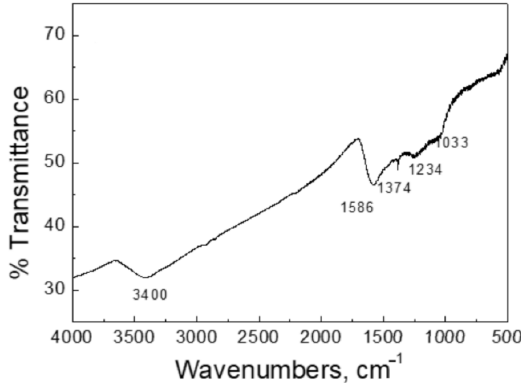
Figure 5. FTIR spectrum of Na–BC.